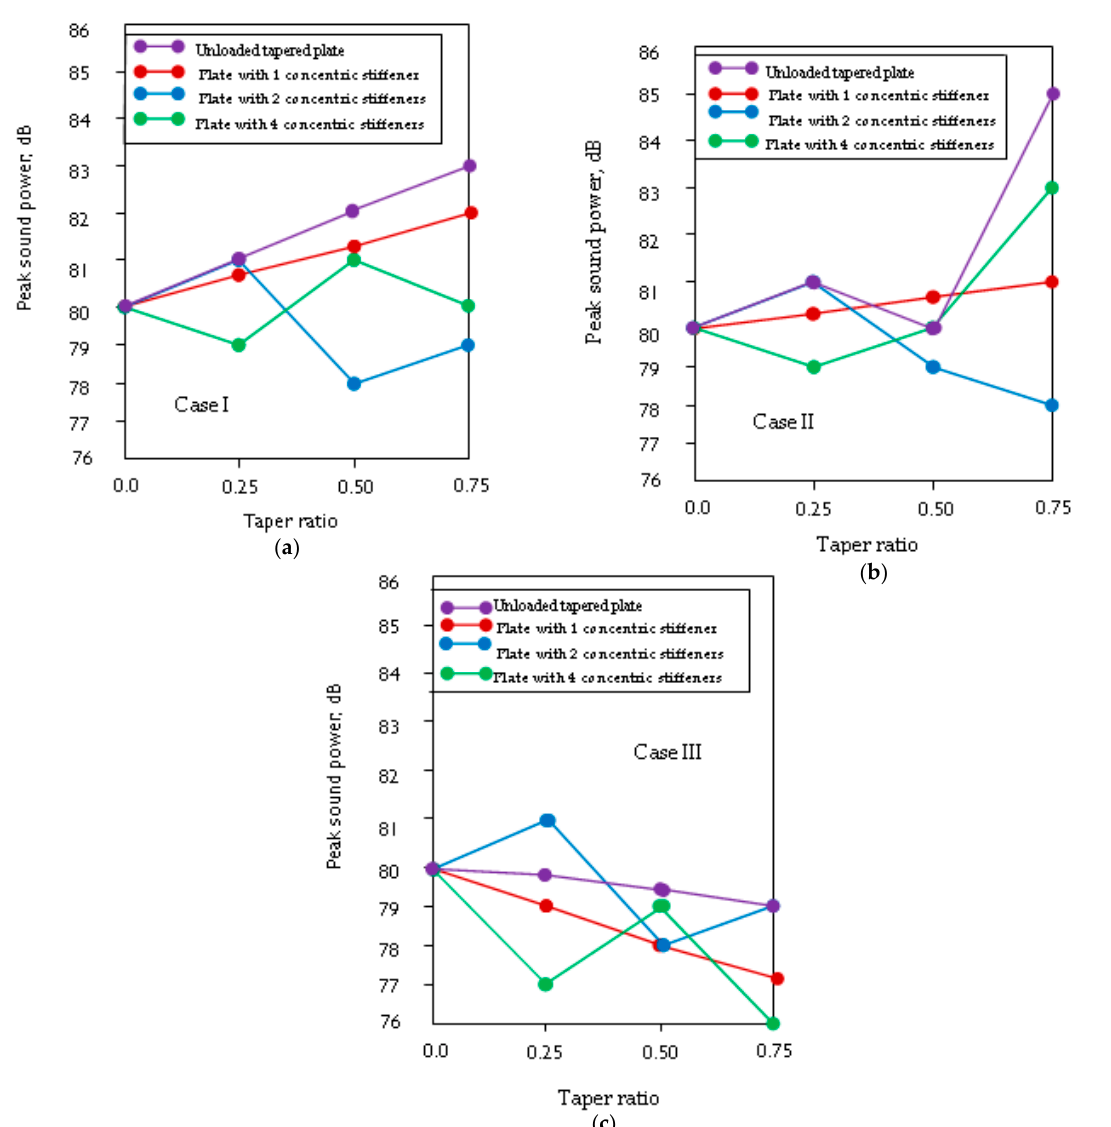
Figure 29. Comparison of peak sound power level (dB) for ( a ) Case I, ( b ) Case II, and ( c ) Case III plates having different parabolic thickness variations with different combinations of concentric stiffener patches.